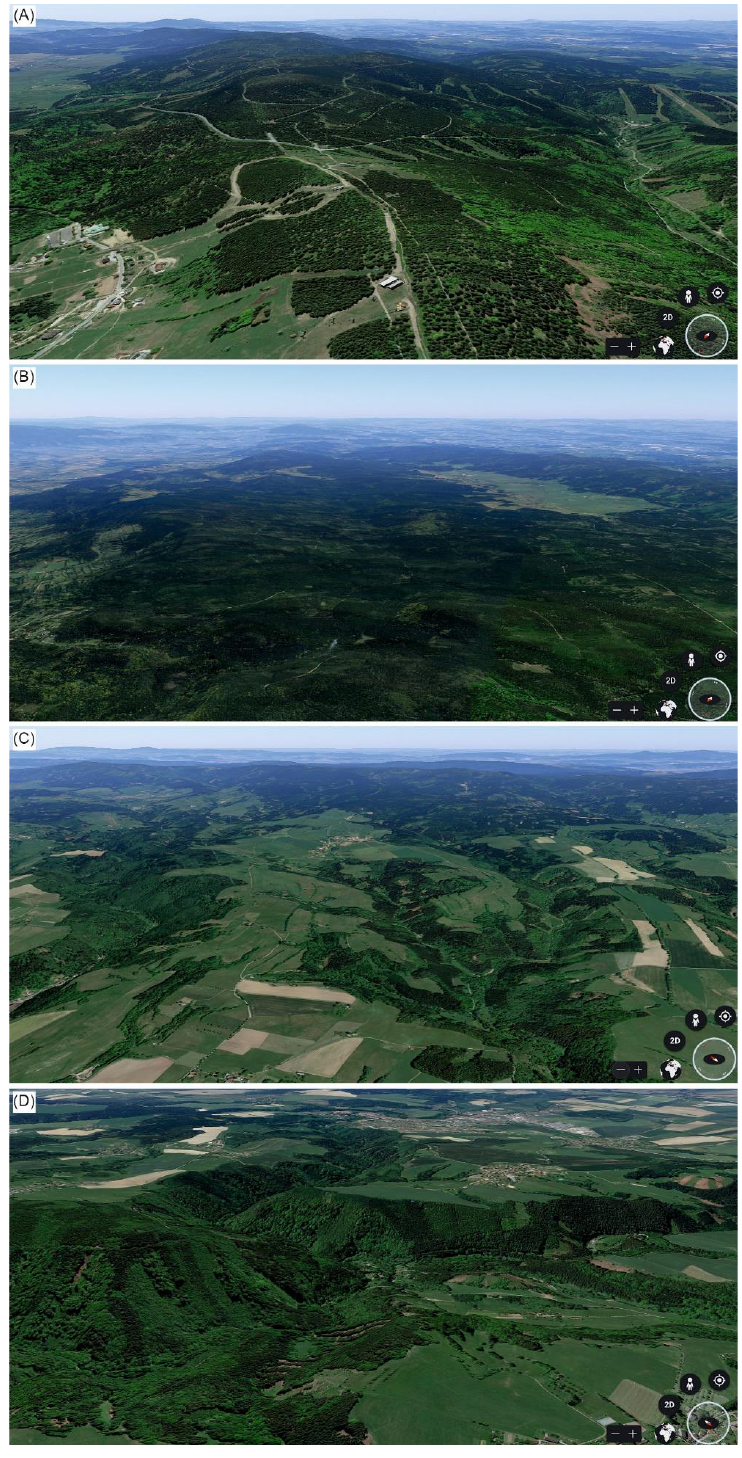
Figure 7. Selected relief features of the Orlické–Bystrzyckie Mountains Block illustrated by Google Earth Pro TM images: ( A ) main ridge of the Orlick é Mts.—view from the north; ( B ) downfaulted steps of the Bystrzyckie Mts.—view from the north; ( C ) dissected ramp on the western side of the Orlick é Mts.—view from the south-west; ( D ) Peklo gorge in the NW part of the Orlick é